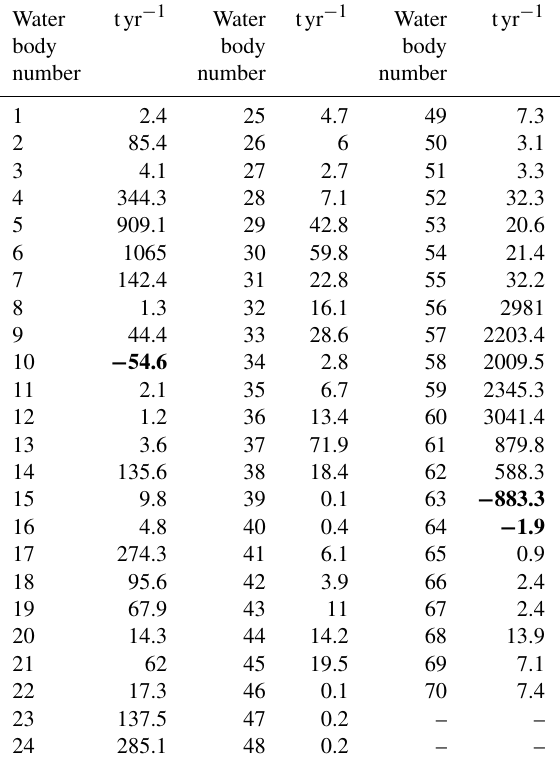
Table 7. Total phosphorous absorption capacity for each profile of Middle Warta water bodies based on characteristic flow SNQ. The negative values are in